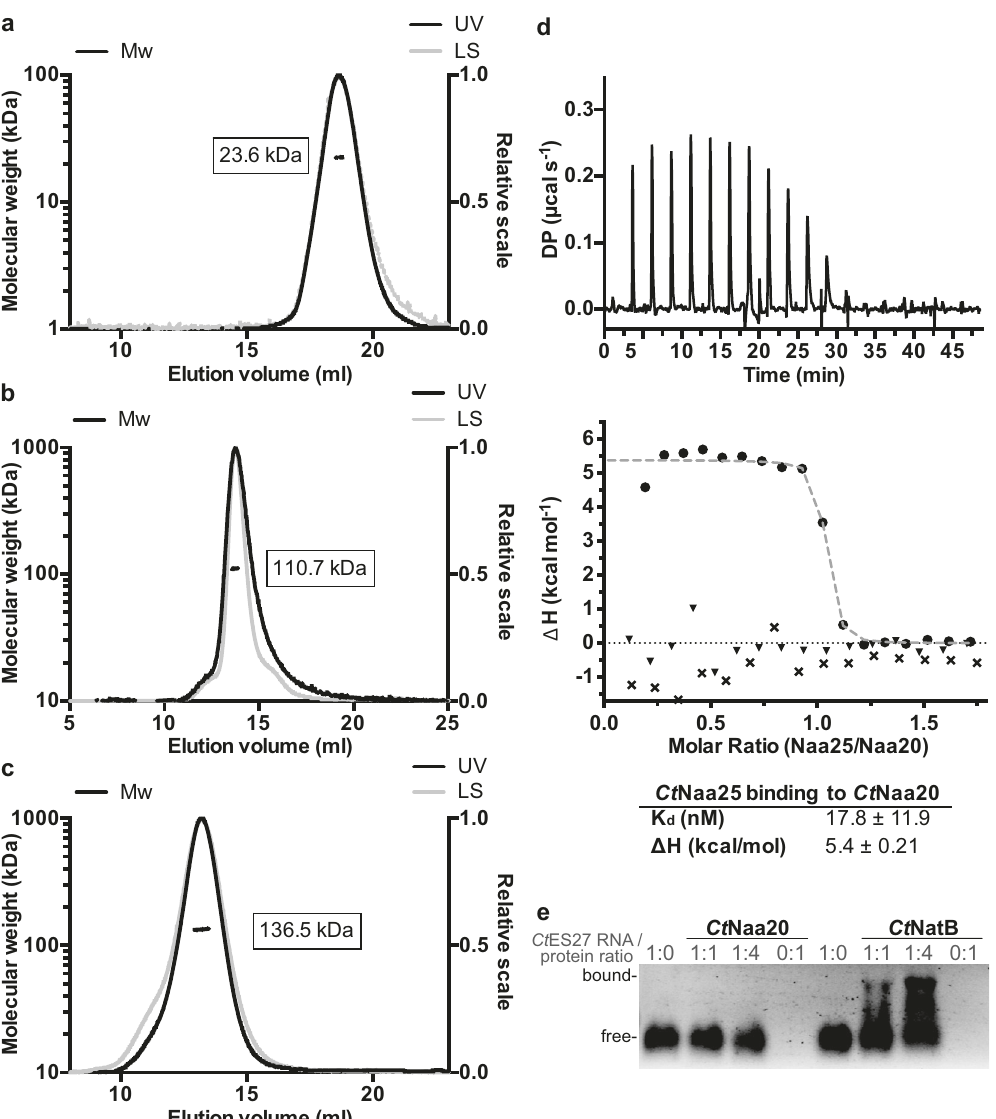
Fig. 1 Characterization of Ct NatB and its subunits. a – c SEC-MALS analysis of Ct Naa20 ( a ), Ct Naa25 ( b ), and Ct NatB ( c ). The experimentally determined molecular weight of Ct NatB, Ct Naa25, and Ct Naa20 is 136.5 kDa (theoretical molecular is 136.1 kDa), 110.7 kDa (theoretical M w is 115.1 kDa), and 23.6 kDa (theoretical M w is 23.1 kDa), respectively. The UV-signals (black) of the corresponding SEC chromatograms are shown together with the light scattering signals (gray) and the mass distributions (black dots). d Isothermal titration calorimetry measurement of Ct NatB complex formation. Ct Naa20 was titrated by Ct Naa25. The signal of one representative measurement is given in differential points (DP) and the dissociation constant K d and binding enthalpy are given in the table. The heats of dilution of the buffer to Ct Naa20 (triangle) and Ct Naa25 to buffer (cross) control runs are represented. Measurements were performed in triplicate and the values represent the means and standard deviations. e Electrophoretic mobility shift assay with the tip of Ct ES27 (expansion segment 27) RNA, Ct Naa20, and Ct NatB. Ct Naa20 and Ct NatB were mixed in different ratios with the RNA and free or bound RNA is